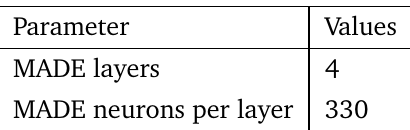
Table 12: IAF model hyper-parameters.